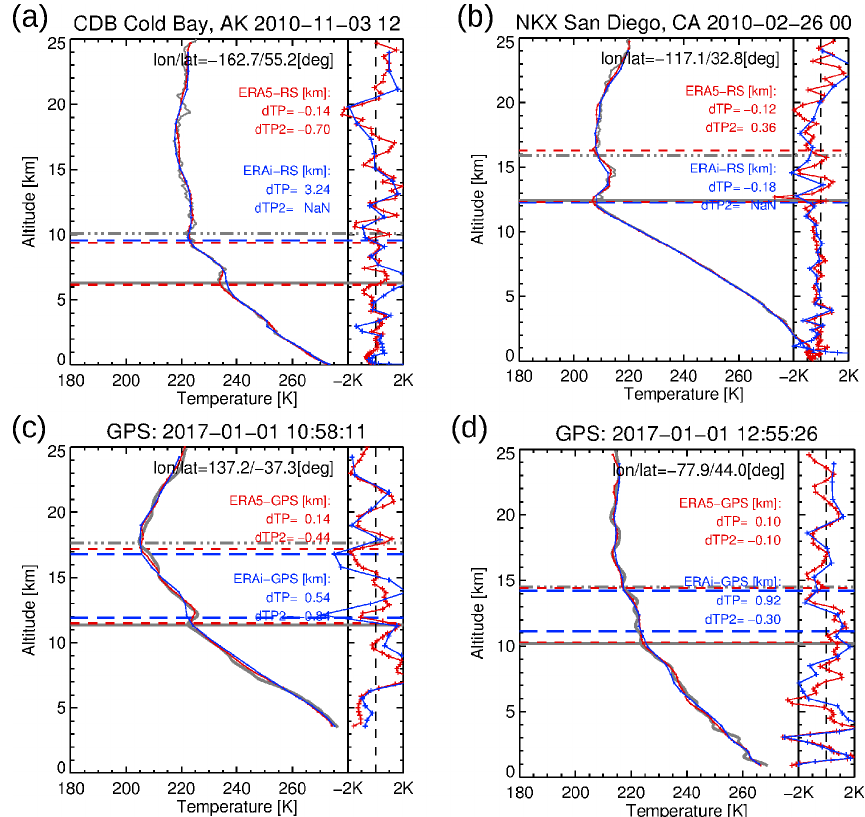
Figure 1. Examples of radiosonde (a, b) and GPS (c, d) temperature profiles (gray) in comparison to ERA5 (red) and ERA-Interim (blue) at different location and time. The right-hand-side profiles show the temperature differences of the reanalyses and the reference data at the vertical resolution of the reanalysis data. Horizontal lines indicate the first and second tropopause height, TPH1 and TPH2, for the radiosondes, GPS, ERA5, and ERA-Interim,